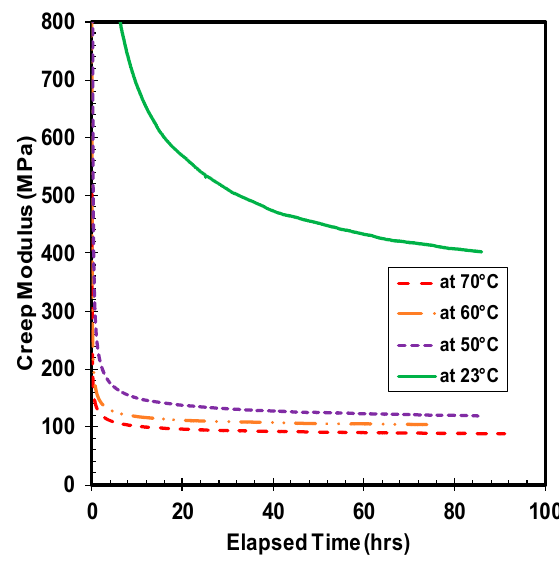
Figure 6. Creep modulus under different temperatures at 14 MPa.